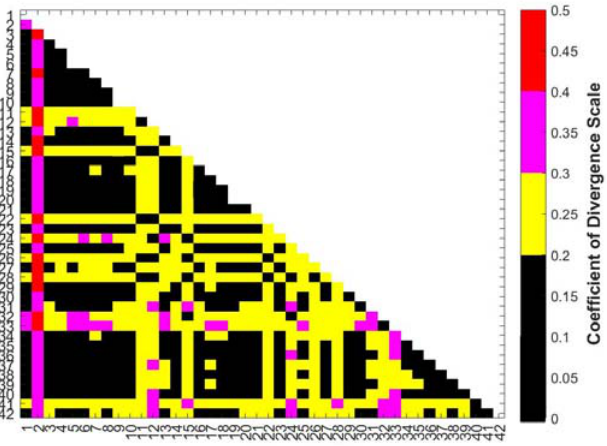
Figure 4. Pairwise hourly coefficients of divergence (COD) for PM 2.5 . As the COD for the majority of pairs is greater than 0.2 there exists heterogeneity on an hourly basis between the sites.